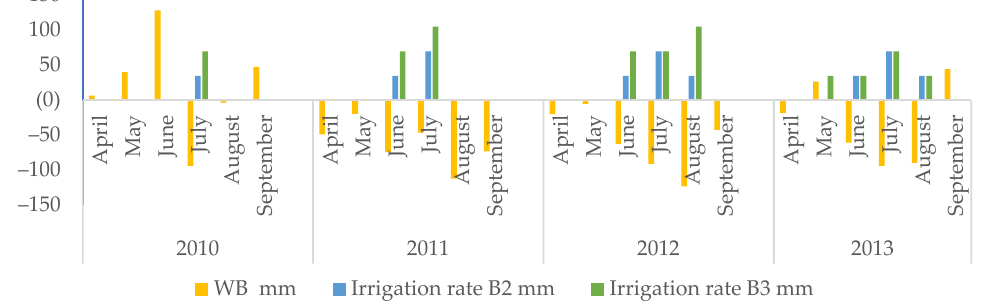
Figure 3. Water balance and irrigation rates (mm/month) in the B2 and B3 irrigation treatments during the four growing seasons (A1–A4).